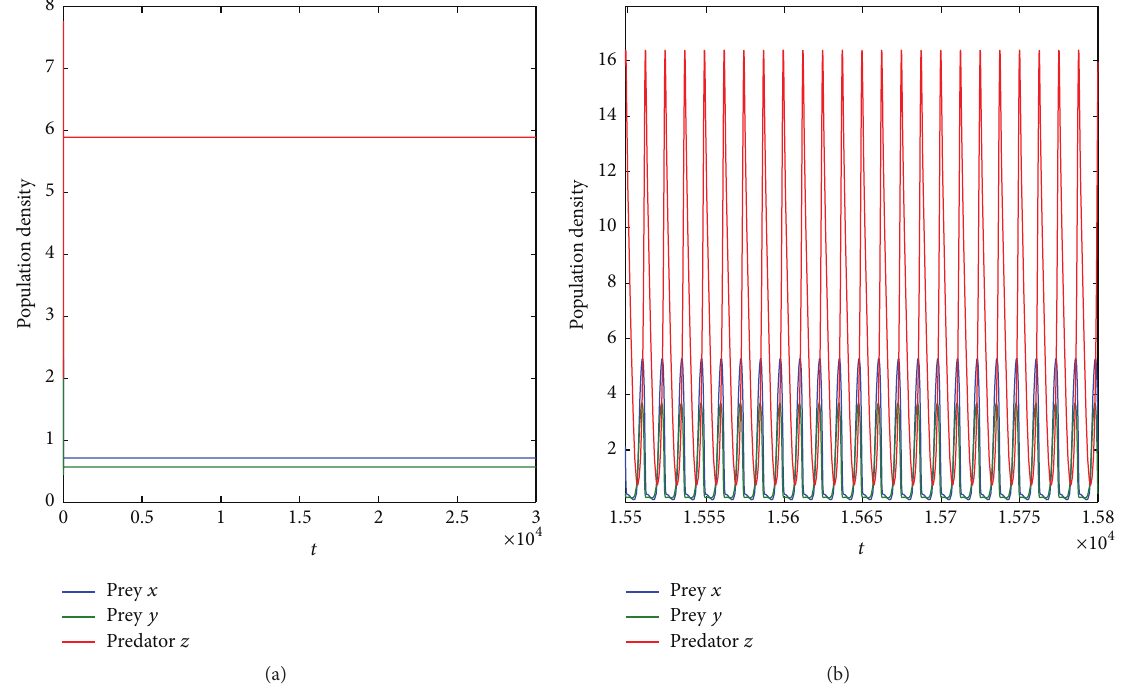
Figure 1: Solution trajectories of system (1) with Holling type III responses ( 𝑝 = 2 , 𝑞 = 2 , 𝑠 = 2 , and 𝑟 = 2 ) showing (a) stable behavior in absence of seasonal perturbations and (b) periodic behavior in presence of seasonal perturbation with data set (45).